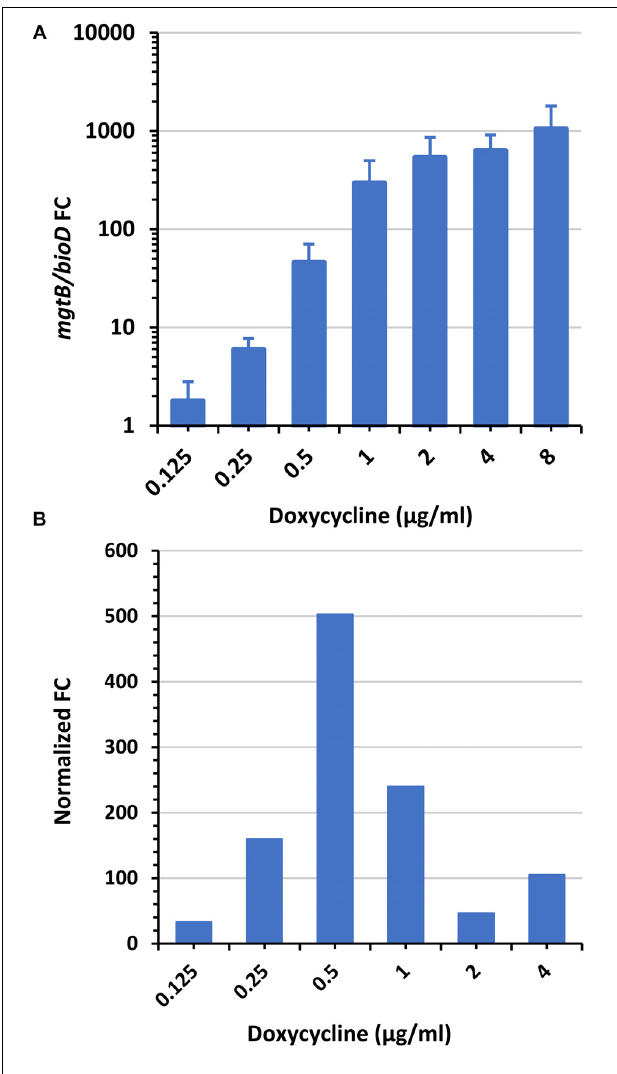
FIGURE 3 | mgtB/bioD FC and normalized FC values as a function of doxycycline concentration. Y. pestis Kim53 culture was exposed to the indicated concentrations of doxycycline. After 2 h, the bacterial cultures were harvested, RNA was extracted and the expression levels of mgtB and bioD (by means of Ct values) were determined using qRT-PCR. (A) mgtB/bioD FC values were calculated for each doxycycline concentration from the Ct values. Bars and error bars are averages and their standard deviations from three independent experiments. (B) The normalized FCs are presented for each doxycycline concentration. The mMIC was determined as the doxycycline concentration with the maximal normalized FC (0.5 µ g/ml). The standard MIC of the bacteria is 0.25–1 µ